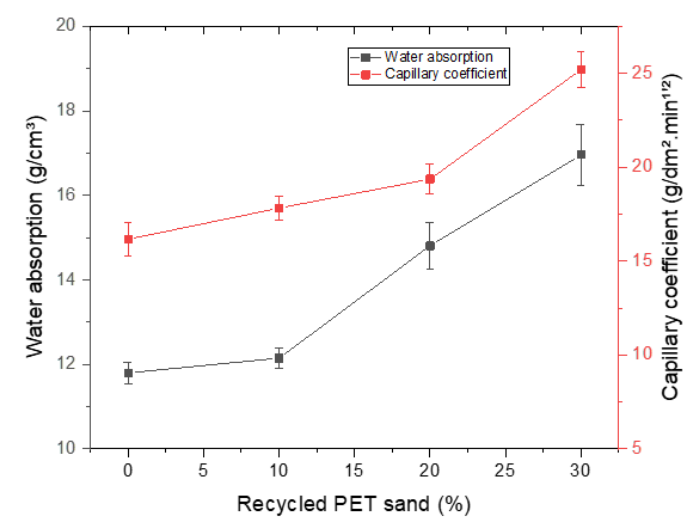
Figure 8. Water absorption and capillary results.